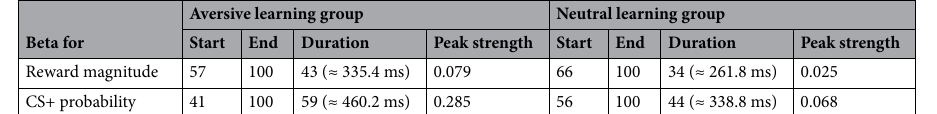
Table 2. Segments of significant beta weights for Reward Magnitude and CS+ Probability in the aversive learning group and the neutral learning group. In the aversive learning group, a time slice corresponds on average to 7.8 ms. In the neutral learning group, a time slice corresponds on average to 7.7 ms. Only segments of more than 10 significant t -tests were accepted as meaningful.